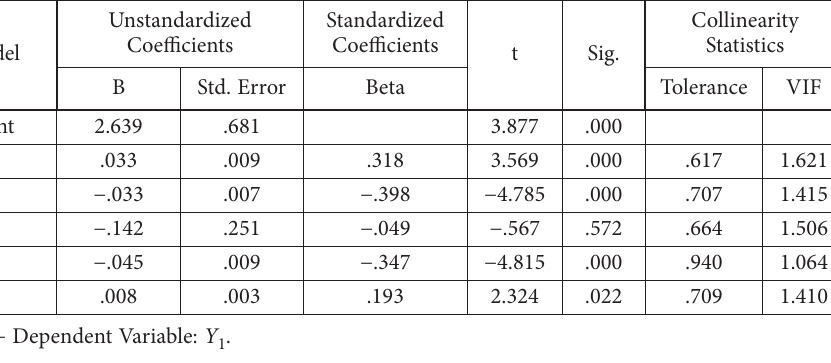
Table 5. VIF values after elimination of X 5 , X 18 and X 19